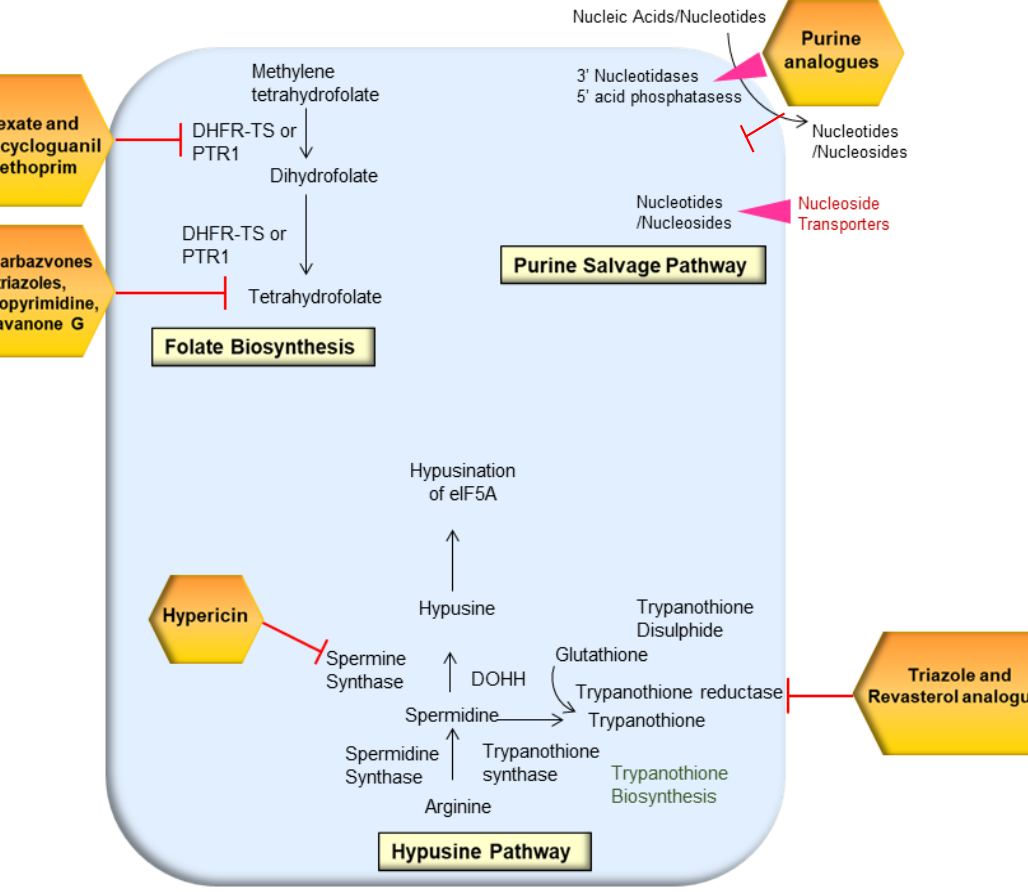
Figure 2. Targeting the folate, purine, and hypusine biosynthesis pathways in Leishmania through a drug repurposing approach.